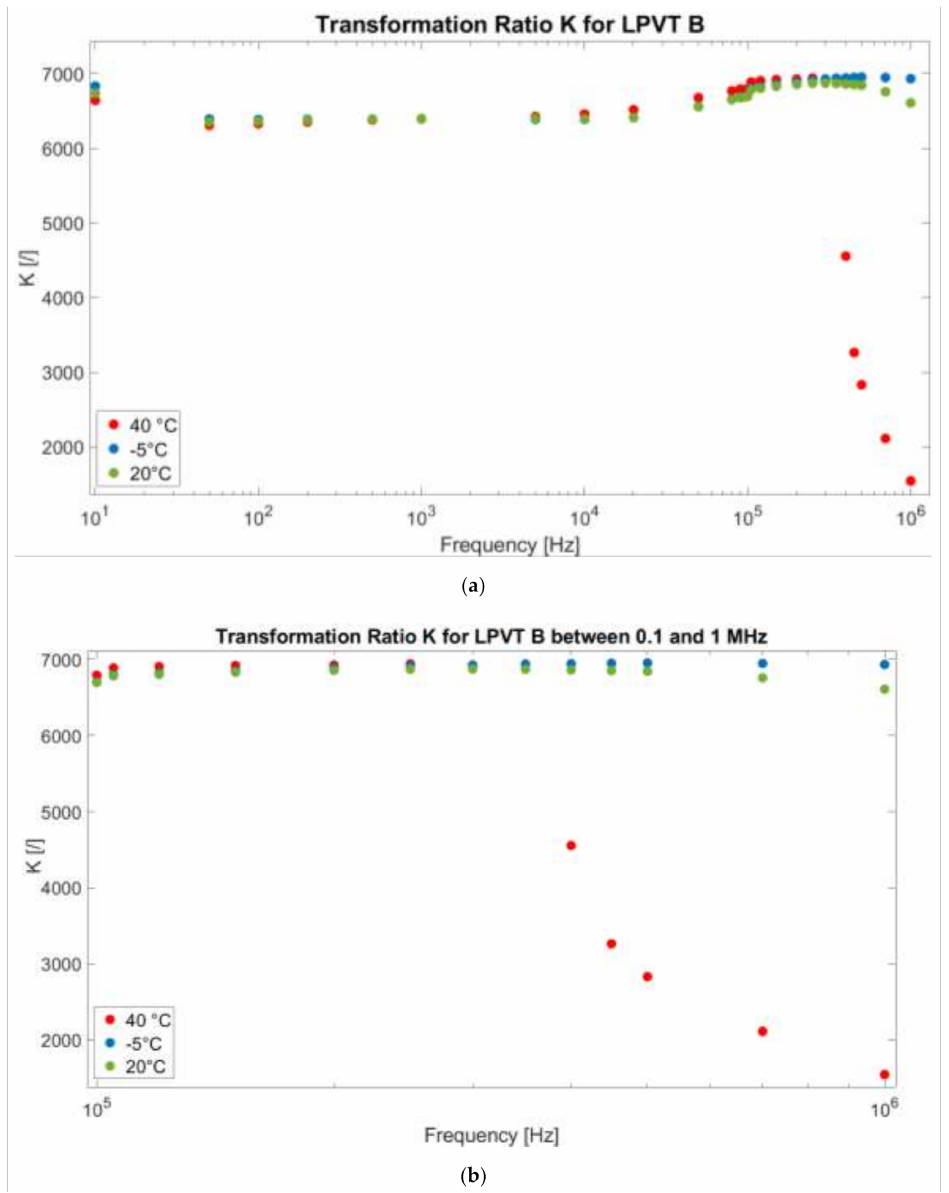
Figure 6. ( a ) Transformation ratio ( K ) as a function of the applied frequency f at 20 ◦ C, 40 ◦ C, and − 5 ◦ C for LPVT B. ( b ) A zoomed-in portion of the graph from 0.1 to 1